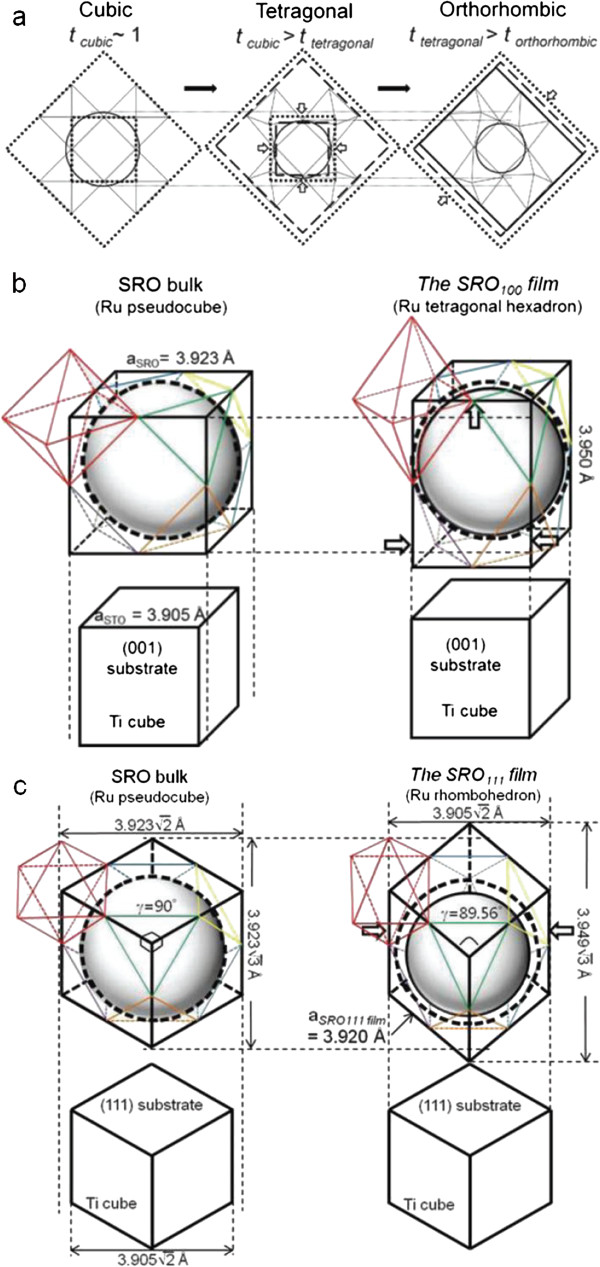
Schematic diagram of structural change in terms of octahedral distortion, hollow inscribed sphere, and its surrounding eight octahedra. (a) Perovskite oxide as the tolerance factor decreases from approximately 1, (b) the SRO100 film, and (c) the SRO111 film with bulk SRO. The Ru nn-distance in the film depended critically on the type of substrate orientation.